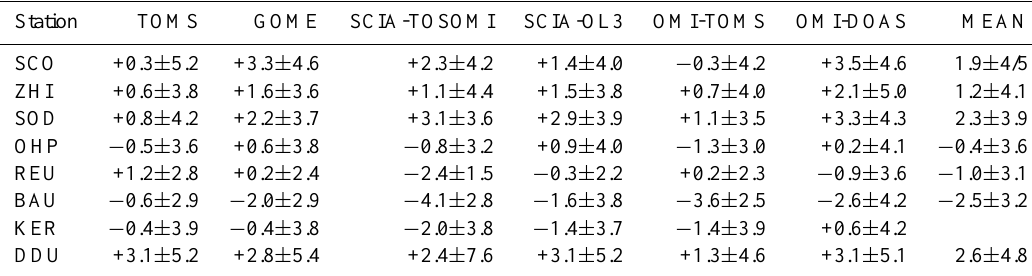
Table 10. Bias and 1 σ dispersion of the relative difference satellite-SAOZ V2 (in %) after temperature (50hPa) and SZA correction. See Table 5 for the meaning of the abbreviations of the stations.